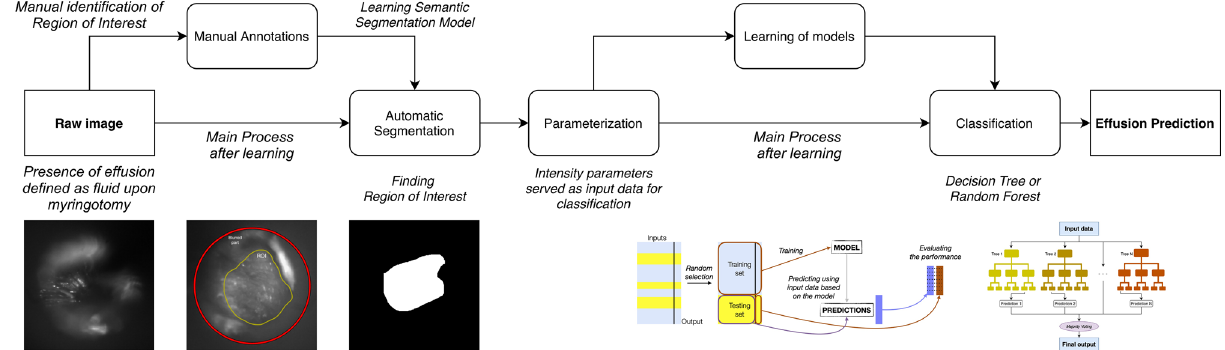
Figure 6. Schematic overview of study protocol. Raw shortwave infrared otoscopic images of the tympanic membrane prior to myringotomy were obtained. An effusion was defined as fluid upon myringotomy. The image frames were manually annotated to identify a region of interest, a process which was then automated. Parameterization followed, using intensity measurements as input data when analyzing each frame. Decision tree and random forest models were then based on the intensity parameters to classify each image and predict the presence of an